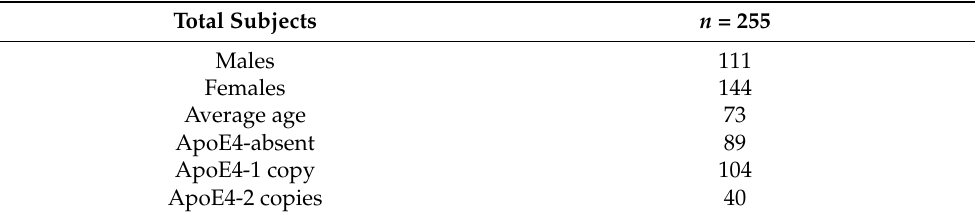
Table 2. Study Participants-Demographics.